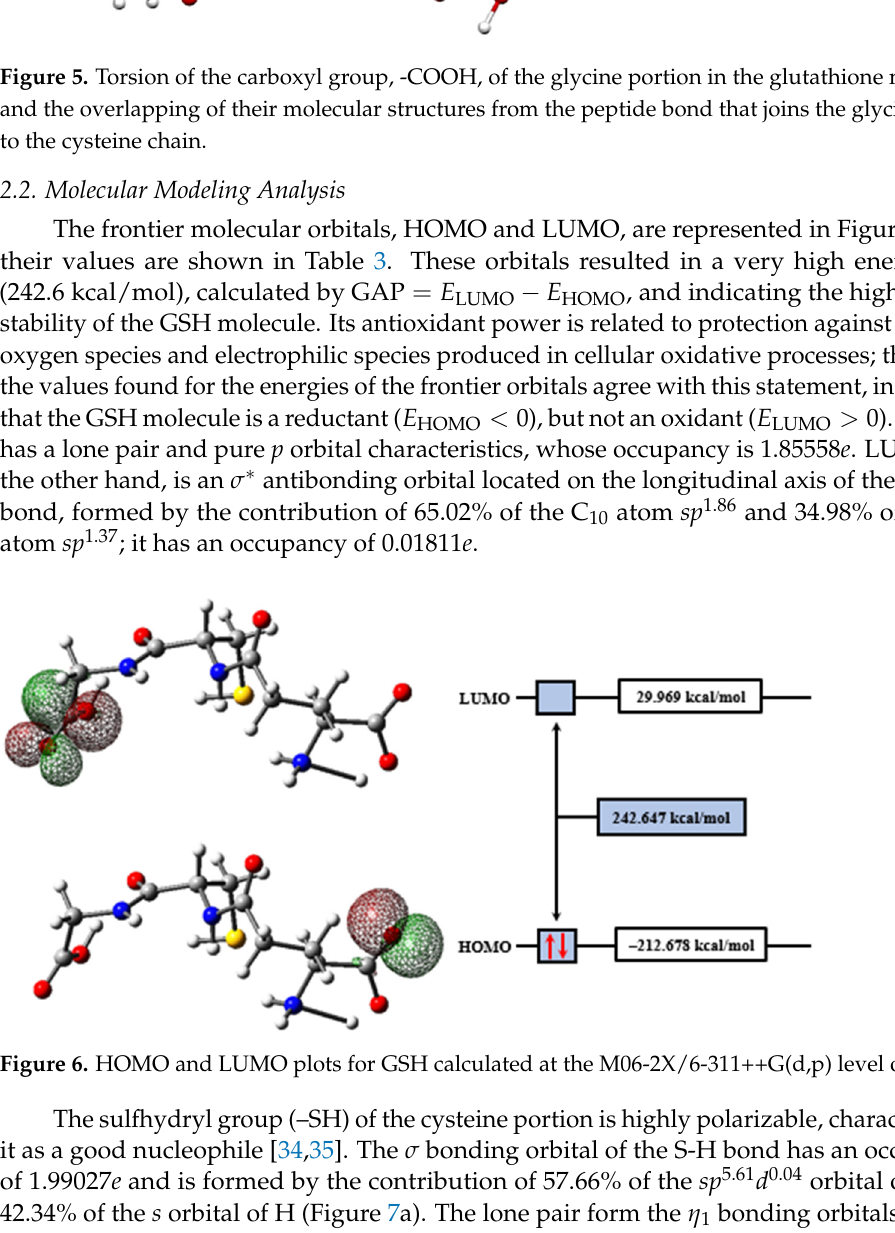
( c ) Figure 7. Isosurface plots of the ( a ) s orbitals of the S-H bond, and of the lone pairs ( b ) 𝜂 (cid:2869) (S) and ( c ) 𝜂 (cid:2870) (S) of the S atom in glutathione, calculated at the M06-2X/6-311++G(d,p) level of theory. From the energies of the HOMO and LUMO, the chemical reactivity descriptors of the GSH were determined as the potential chemical, 𝜇 = (cid:3436)𝜕𝐸 𝜕𝑁(cid:3440) (cid:3100) = − 𝐼 + 𝐴 2 = −𝜒, (2) chemical hardness